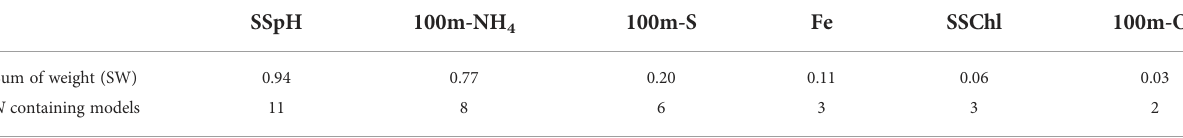
TABLE 3 Relative importance of predictor variables (calculated as the sum AIC weights from models that contain that variable within the 95% con fi dence interval) for P. regalis .